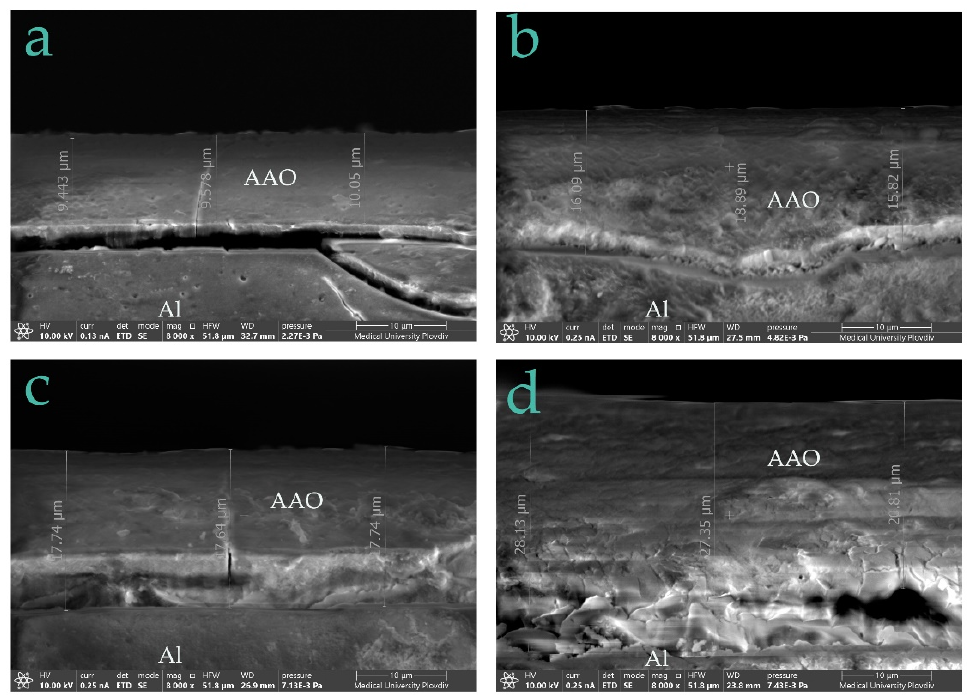
Figure 2. Microphotographs at the edges of ( a ) unsealed specimen of group A, ( b ) sealed specimen of group A, ( c ) unsealed specimen of group B, and ( d ) sealed specimen of group B at ×8000 magnification. Table 2. Anodic film thickness, acquired from SEM analyses. Sample Groups